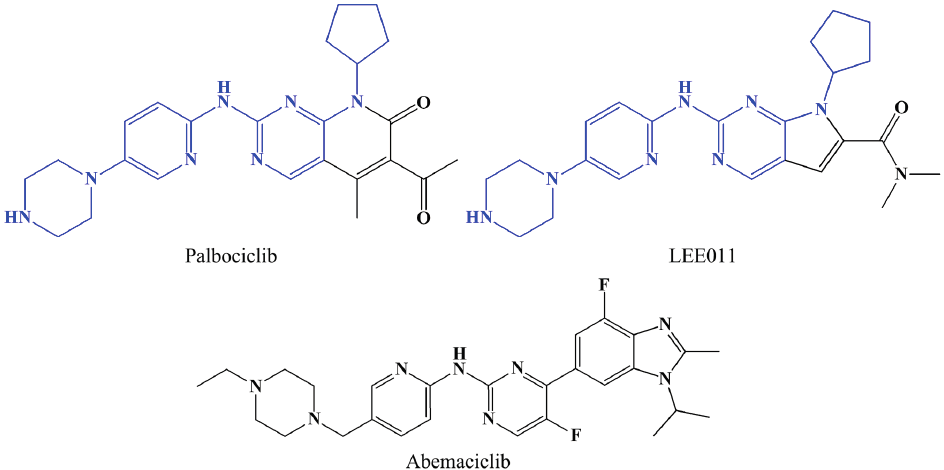
Figure 5. Three CDK4/CDK6 inhibitors in